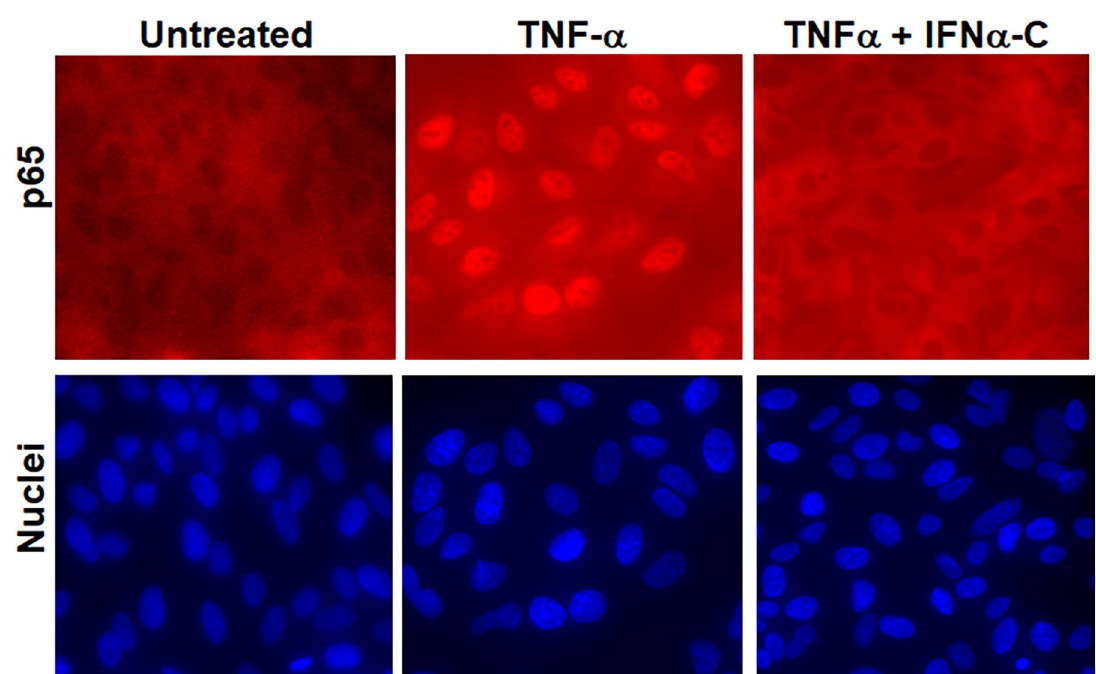
Fig 2. Suppression of NF- κ B signaling by IFN α -C. ARPE-19 cells were seeded on 8 well microscopic slides and grown overnight. They were taken in low serum medium and treated with IFN α -C (3 μ M) for 2 hr followed by treatment with TNF α (50 ng/ml) for 30 min. Cells were fixed, permeabilized with 1% Triton X-100 (in PBS) and stained with an antibody to p65, followed by staining with Cy3-conjugated secondary antibody and DAPI and imaged using fluorescence microscopy at